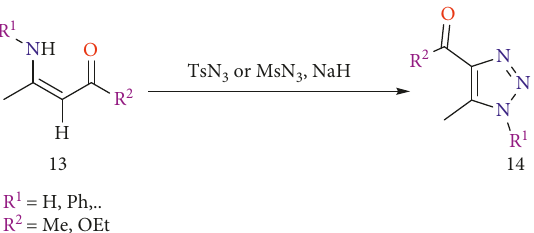
Scheme 8: Synthesis of 1,2,3-triazoles from Sulfonyl Azides with Enaminones.